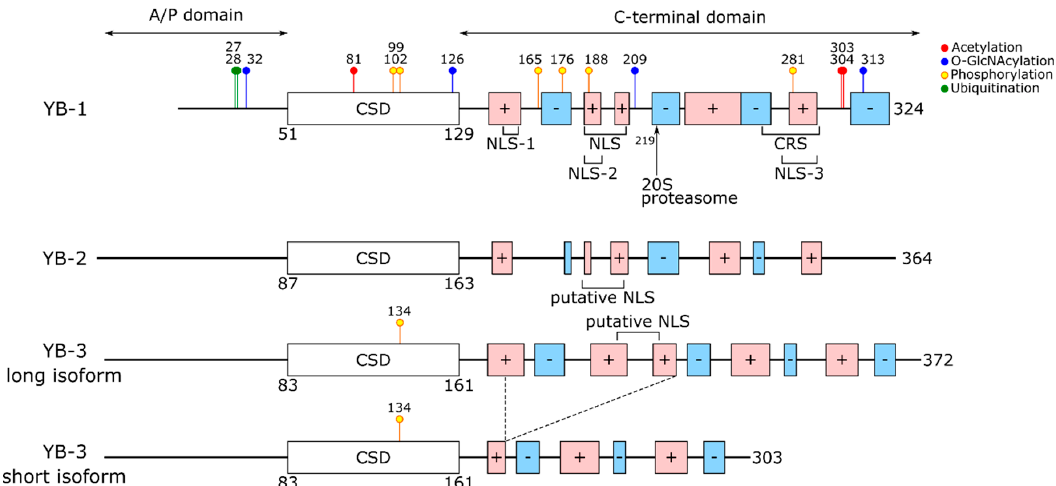
Figure 1. Domain organization of Y-box binding proteins (YB proteins). A/P domain, alanine/proline-rich domain; CSD, cold-shock domain; NLS, nuclear localization signal; CRS, cytoplasmic retention signal. Clusters of positively and negatively charged amino acid residues are shown in red and blue, respectively. Modifications of YB proteins are indicated here and presented in Table 1 (see below).